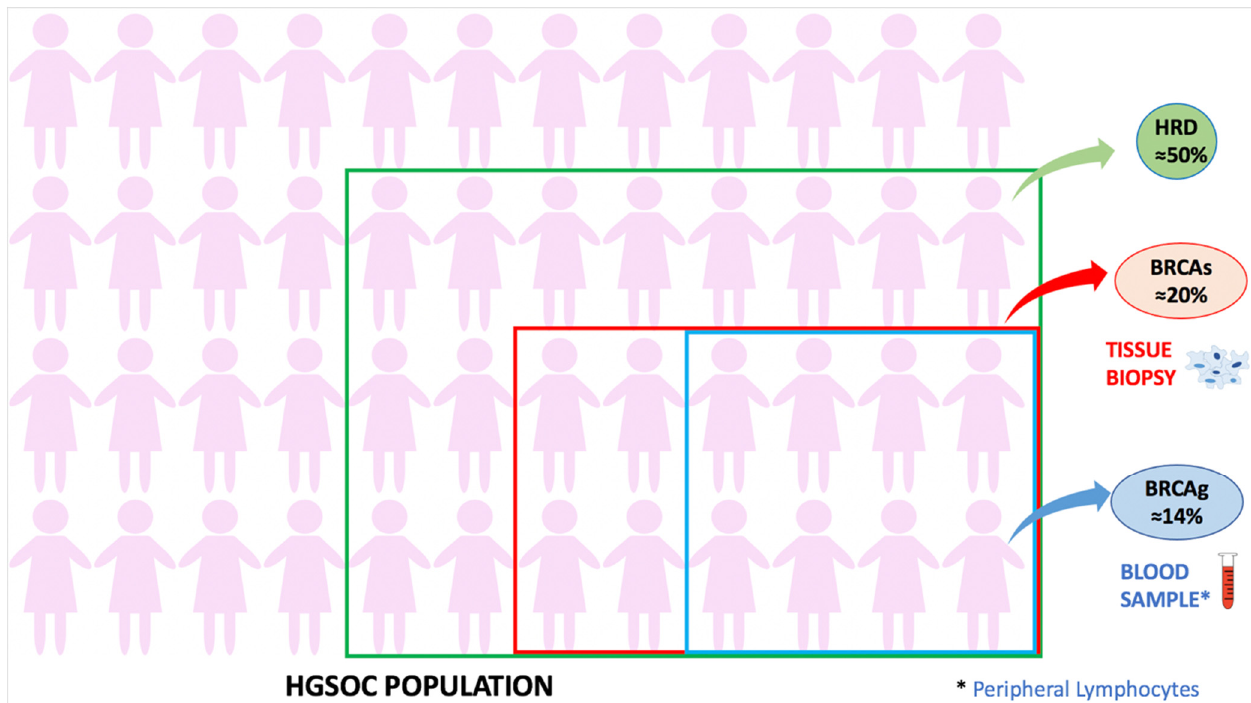
Figure 4. HRD and BRCA1/2 mutation in HGSOC. Approximately 50% of HGSOCs have homologous recombination deficiency (HRD). Among genes, BRCA1/2 are the most common involved: about 14% of HGSOC patients were reported to have BRCA1/2 mutation detectable in a blood sample (germinal mutation, analysis of peripheral Lymphocytes). While a BRCA1/2 mutation found only in a tissue sample is present in about 20% of the affected women (somatic mutation). Other genes with a role in HRD are CDK12 (3% of cases), RAD51C (2%), EMSY (6%), and PTEN (7%).